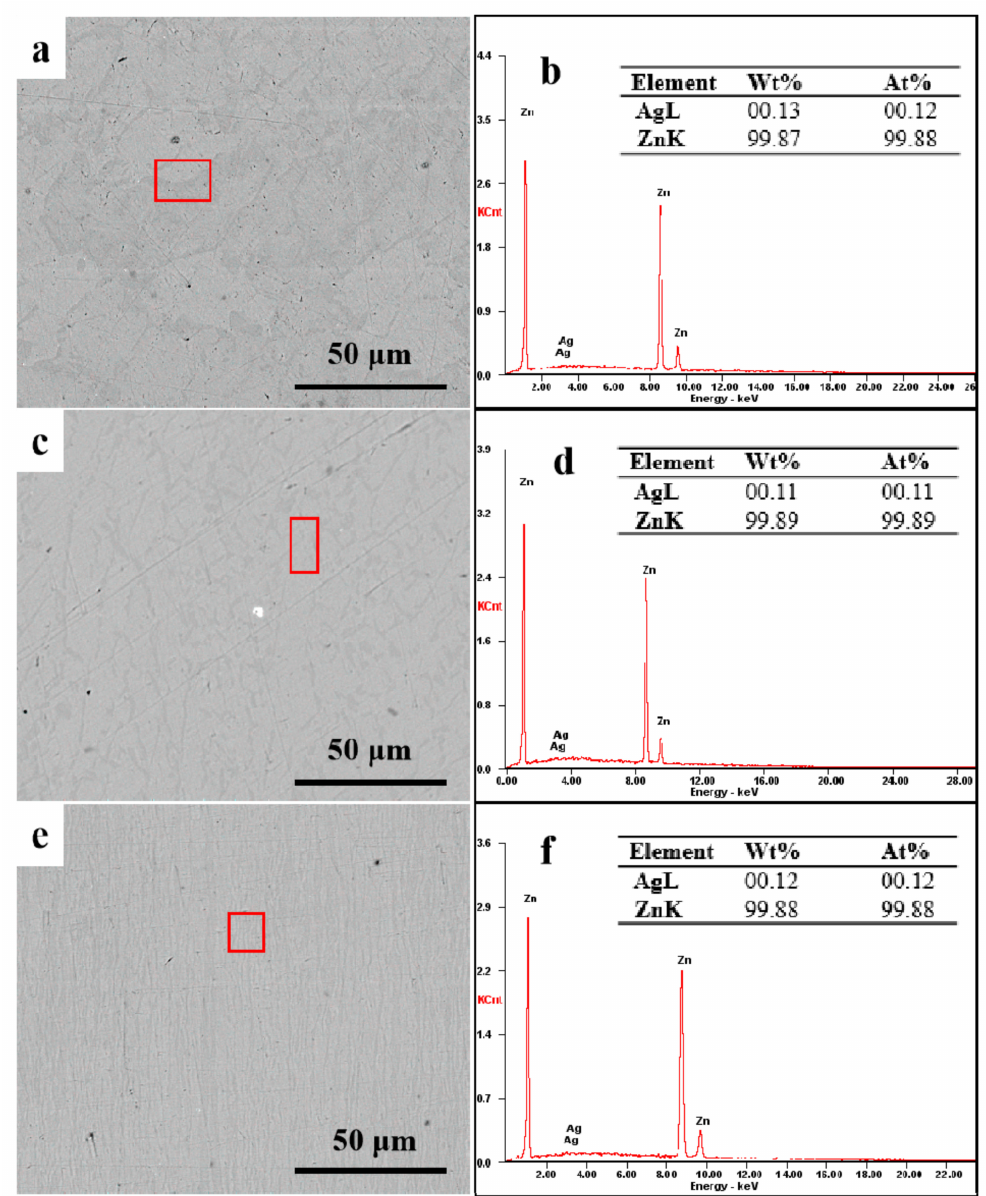
Figure 3. SEM microstructures and EDS analyses of the Zn-0.5%Li-0.1%Ag alloy in different treatment states: ( a , b ) as-cast, ( c , d ) extruded, and ( e , f )